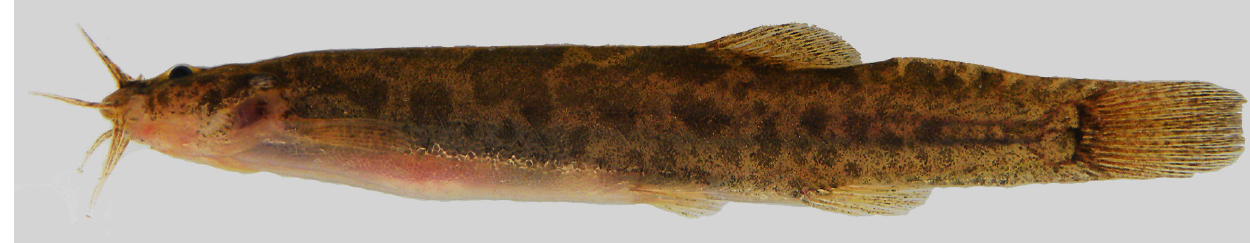
FIGURE 27 | Specimen in life out of the water of Scleronema teiniagua (ZVCP 13763), Uruguay, Artigas, arroyo Catalán Grande at Paso Santiño, río Cuareim basin lower río Uruguay. Photograph taken by Sebastián